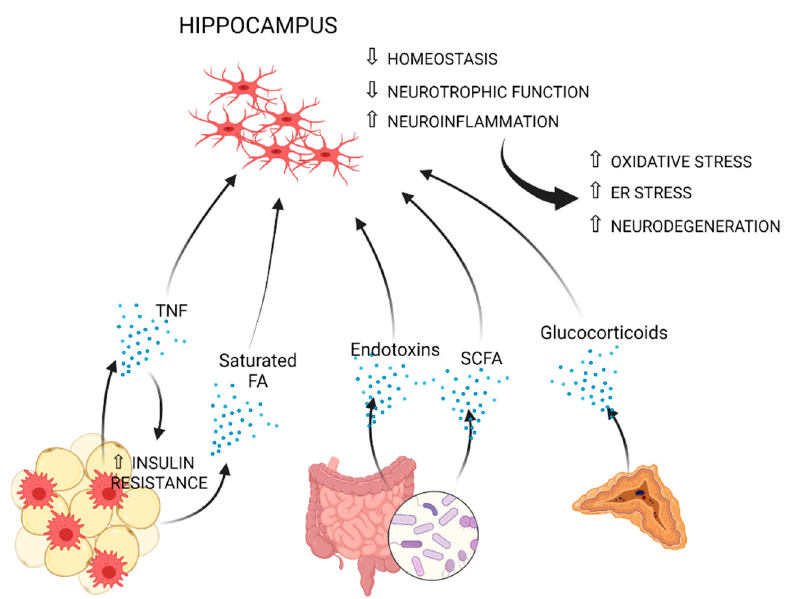
Figure 1. Peripheral immune, metabolic and endocrine routes, which may promote hippocampal microglial inflammation in obesity. Adipose-tissue-derived TNF and saturated fatty acids may exert microglial pro-inflammatory effects in the hippocampus. TNF promotes insulin resistance in the adipose tissue, which leads to enhanced lipolysis, further increasing the amount of saturated fatty acids in the circulation [10,88,89,140,188]. Gut microbiome-derived endotoxins and SCFA may also induce hippocampal neuroinflammation [189,190]. Chronically enhanced adrenocortical secretion of glucocorticoids may sustain microglia-mediated inflammation and neurodegeneration [191–193]. Collectively, these signals can lead to compromised homeostatic and neurotrophic function and sustained inflammatory activation of microglia, associated with oxidative stress, ER stress and neu- rodegeneration in the hippocampus [193–204]. Table 1. Factors that are discussed as mediators of the effects of obesity on microglia-mediated neuroinflammation. Factor